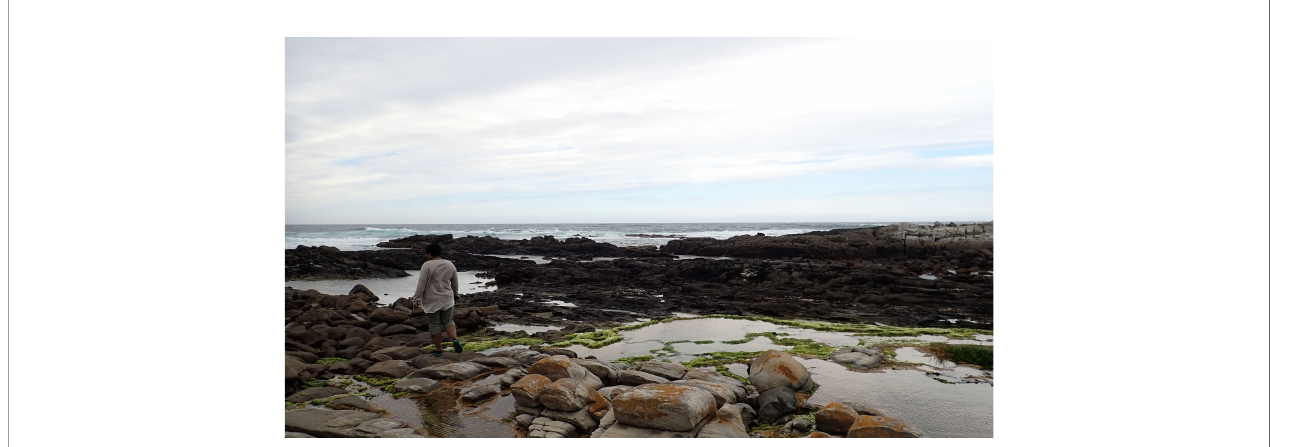
FIGURE 10 | Nozipiwo Hambaze walking along the stromatolites on the coast near Schoenmakerskop,